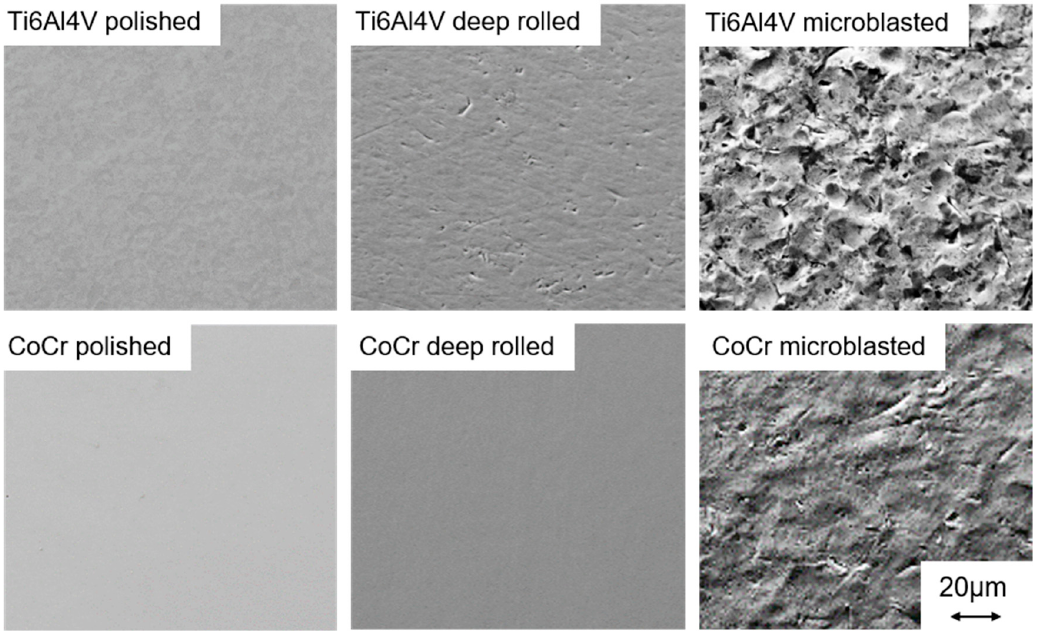
Figure 2. Scanning electron microscope images of the polished, deep-rolled and microblasted Ti6Al4V and CoCrMo (CoCr) samples.